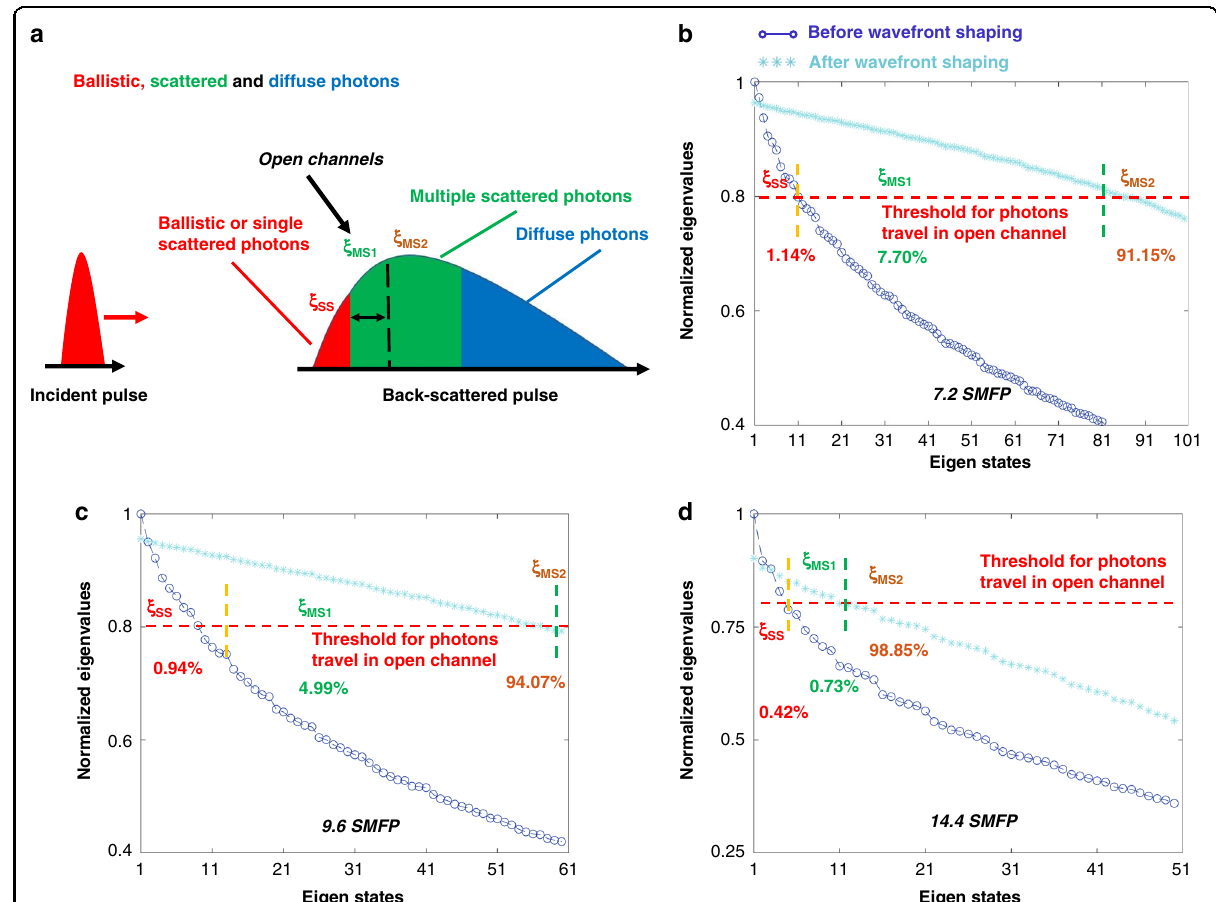
Fig. 4 Controlling the ξ MS1 photons to travel in open channels. a Simple illustration of light pulse re fl ected from a turbid medium. b – d show the percentages of ξ MS1 photons under control at the depth of 7.2 SMFP, 9.6 SMFP, and 14.4 SMFP,